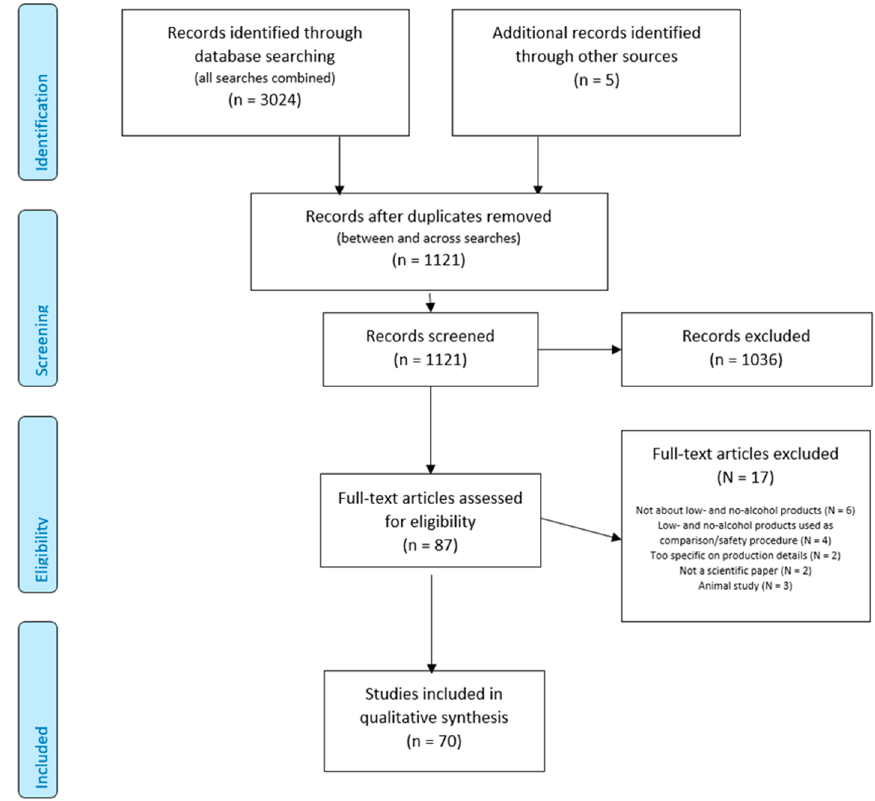
Figure 1. PRISMA flow diagram.